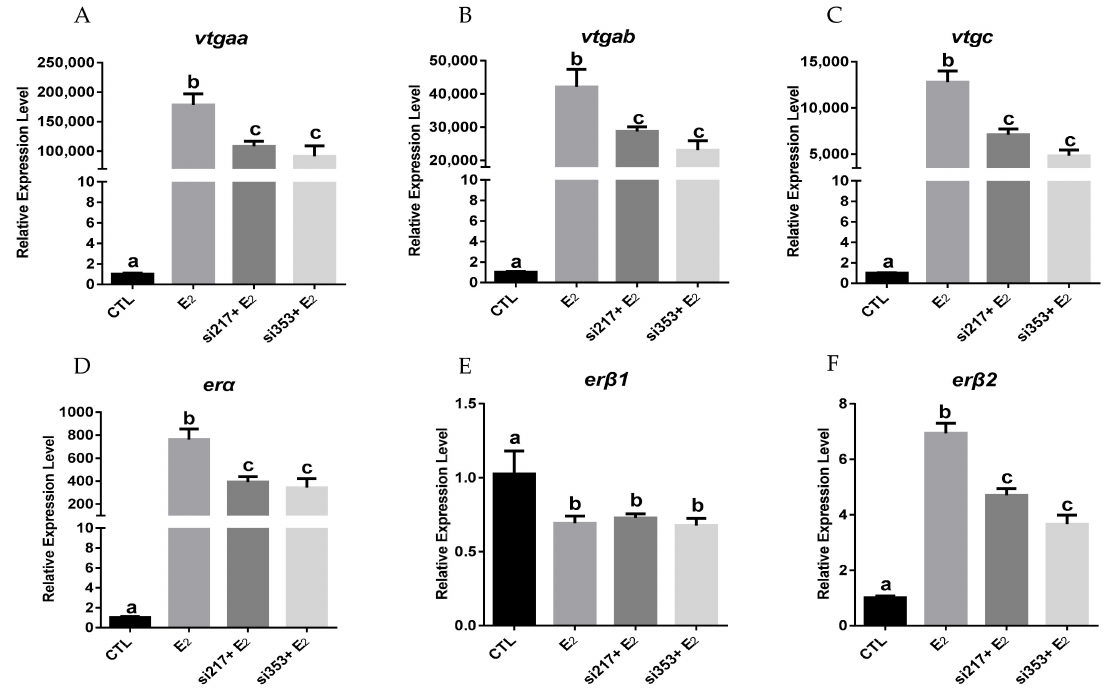
Figure 7. Effects of siRNA knockdown on the expression of vtgs and ers in primary hepatocytes: ( A – F ) the mRNA levels of vtgaa , vtgab , vtgc , er α , er β 1 and er β 2 in the hepatocytes. The cells were transfected with si217 or si353 (5 µ g /mL), and then treated with 0.01 µ M E 2 for 24 h. Data are expressed as the mean ± SEM ( n = 4) and analyzed by one-way ANOVA followed by Tukey’s post-hoc test. Different letters above the error bars indicate statistical differences at p <